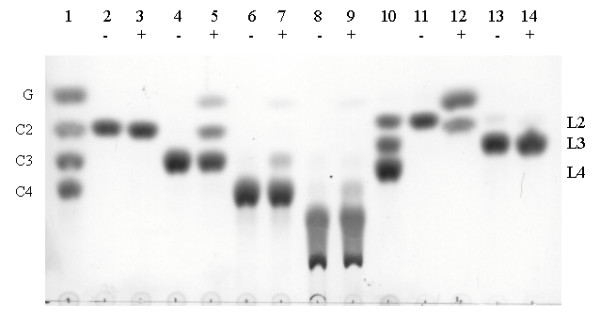
Hydrolysis of oligosaccharide substrates by Os4bglu12 detected by TLC. The Os4bglu12 was incubated with 5 mM substrates for 30 min and the products were detected after TLC by the carbohydrate staining. Samples were incubated with (+) or without (-) enzyme. Lanes: 1, glucose (G) and cello-oligosaccharides of DP 2–4 (C2-C4) marker; 2 and 3, cellobiose; 4 and 5, cellotriose; 6 and 7, cellotetraose, 8 and 9, cellopentaose, 10 laminari-oligosaccharides of DP 2–4 (L2-L4) marker; 11 and 12, laminaribiose; 13–14 laminaritriose.